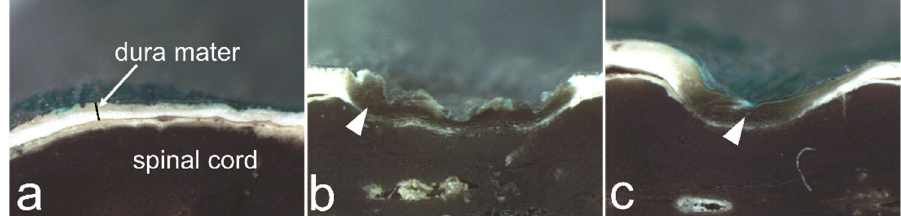
Figure 5. Examples of changes observed in the dura mater with stereomicroscopy. ( a ) Control. ( b ) Dural indentation and dark brown discoloration (arrowhead; 50 g load, no covering). ( c ) Dural indentation and dark brown discoloration (arrowhead; 50 g load, covered with a neurosurgical cotton pattie).